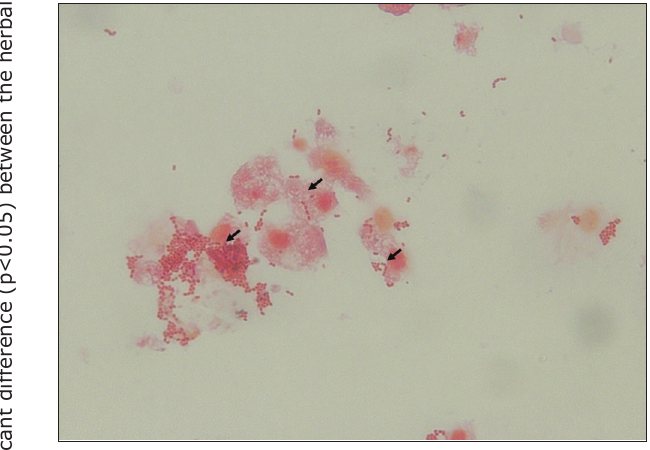
Figure-1: Ability of L. acidophilus (black row) to adhere to intestinal epithelial cells as observed through Gram staining (1.000×). T